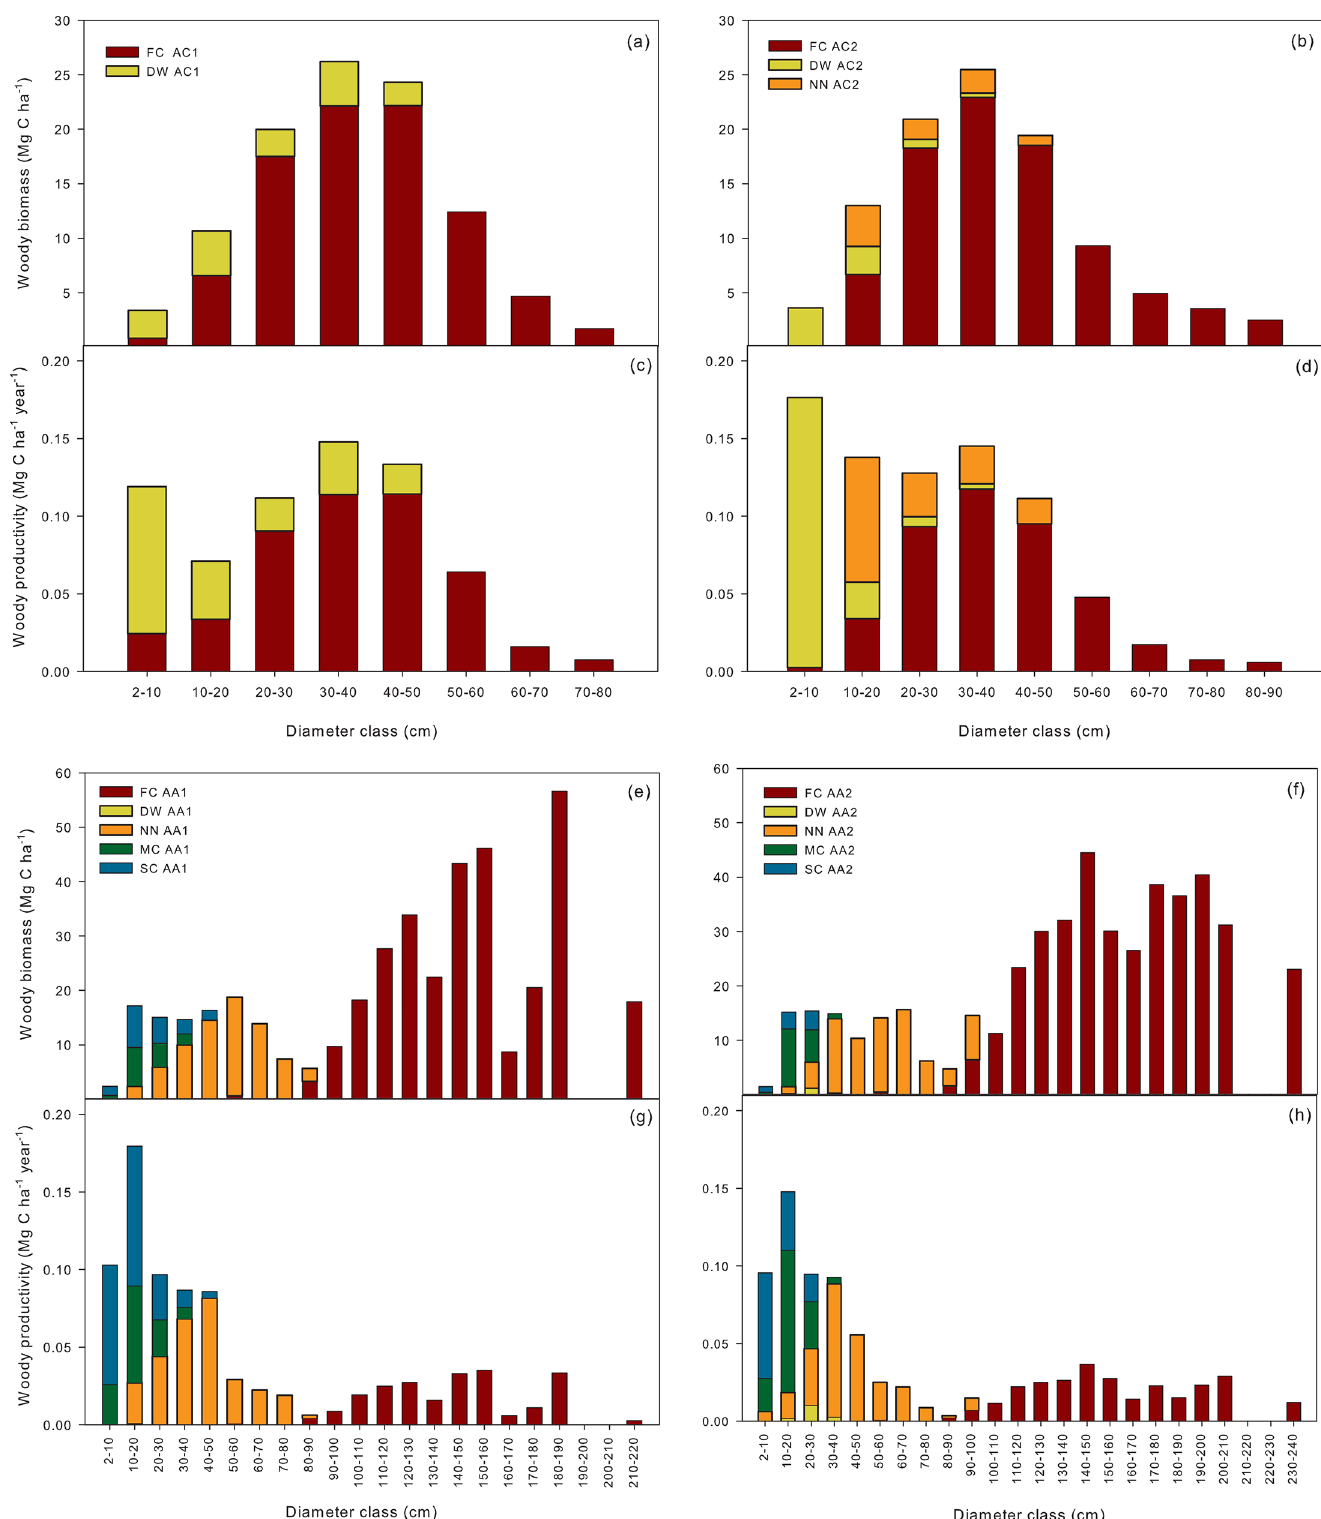
Fig 3. Aboveground woody biomass and productivity per species and diameter classes. a), b), e), f) aboveground woody biomass for each of the most important species along different diameter classes in Alerce Costero and Alerce Andino plots. c), d), g), h) the same as in a), b), e), f) respectively, but